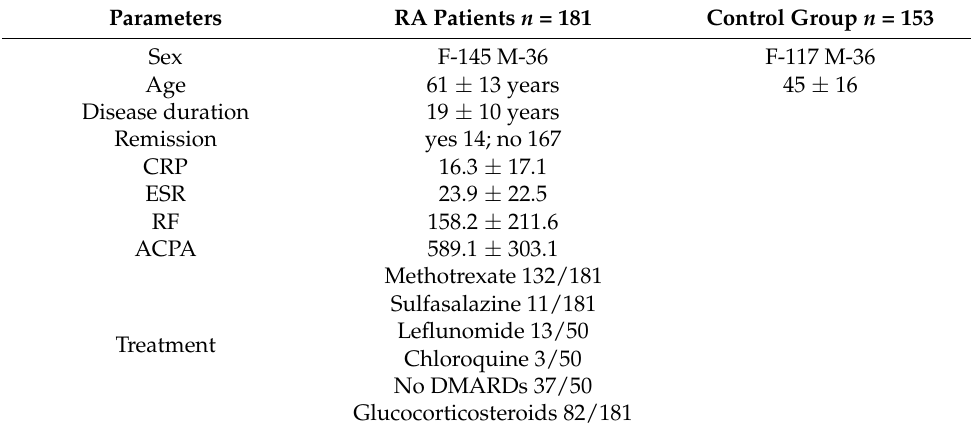
Table 1. Data present the clinical characteristics of the studied group with the mean values of parameters ( ± SD).